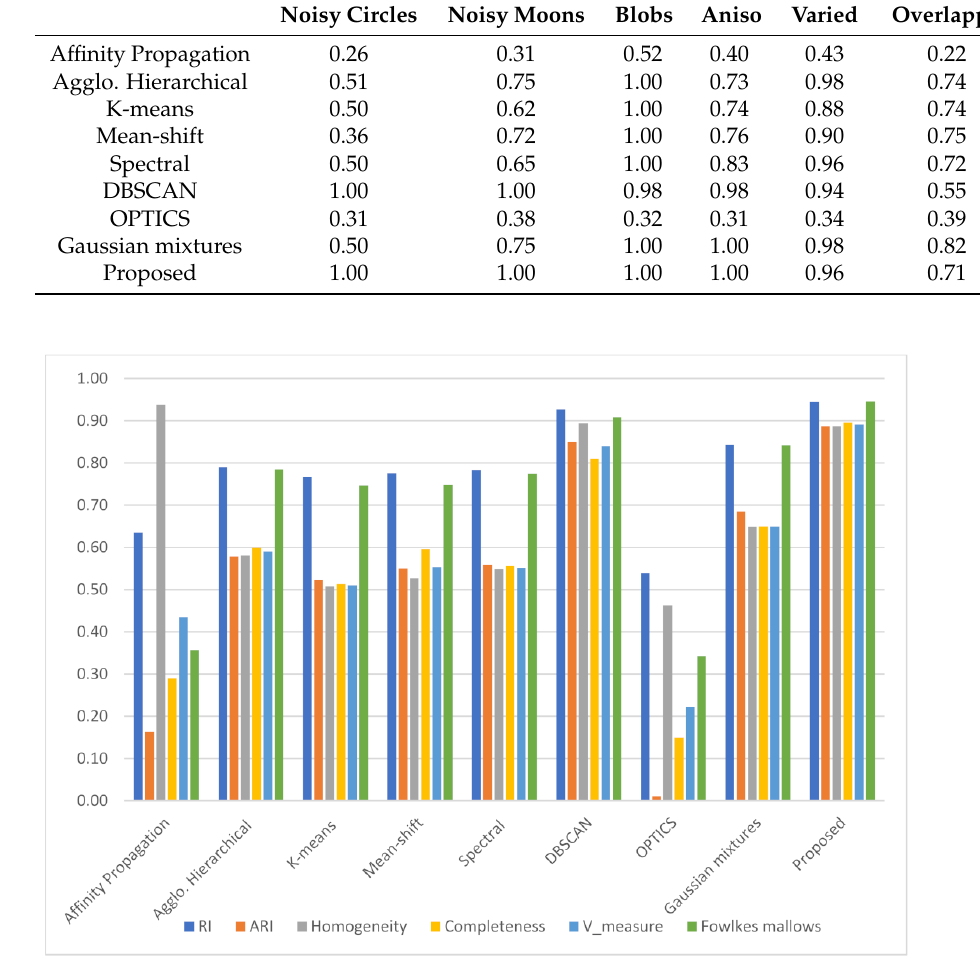
Figure 9. The average of RI , ARI , homogeneity, completeness, and Fowlkes–Mallow’s score. Note: measurements of affinity propagation, agglomerative hierarchical, k-means, mean-shift, spectral, DBSCAN, OPTICS, Gaussian mixtures, and the proposed clustering